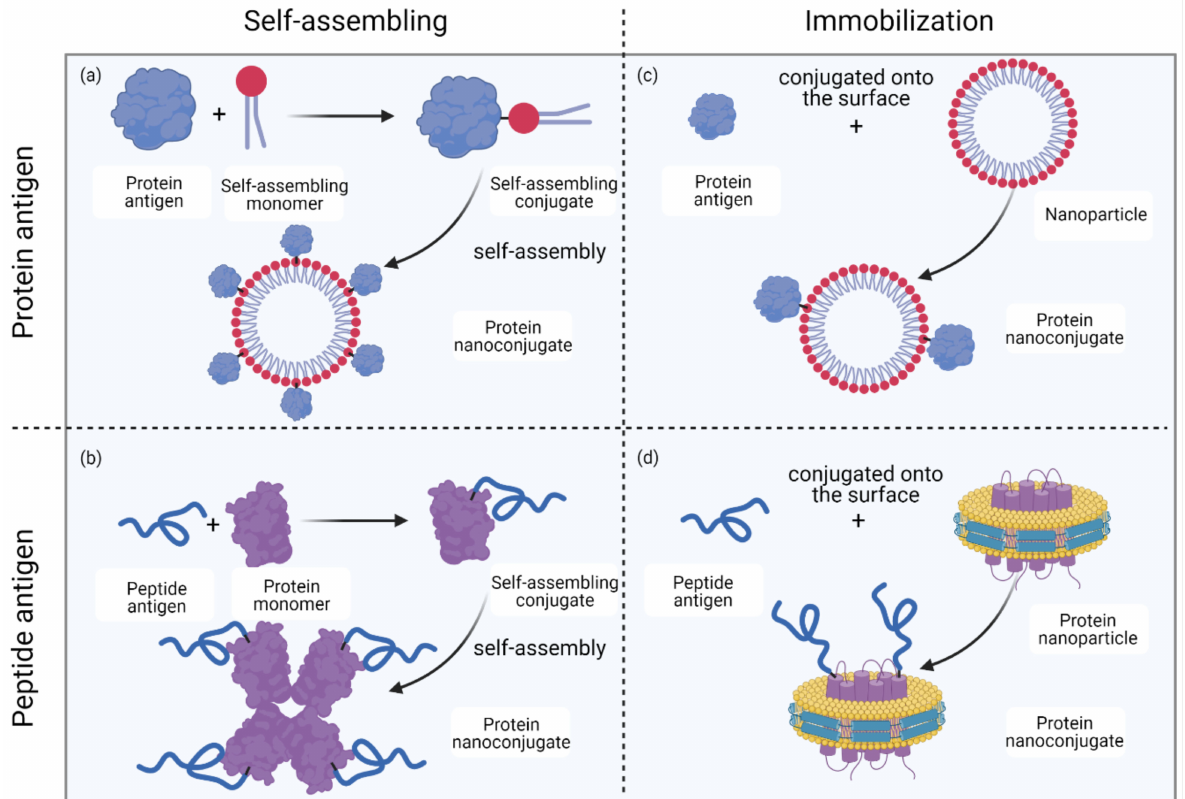
Figure 12. Methods for protein nanoconjugate formation. ( a ) Protein antigens are conjugated to self-assembling monomers; the conjugates then self-assemble into protein nanoconjugates. ( b ) Peptide antigens are conjugated to protein monomers; the conjugates then self-assemble into protein nanoconjugates. ( c ) Protein antigens are conjugated to the surface of nanoparticles (NPs) to form protein nanoconjugates. ( d ) Peptide antigens are conjugated to the surface of NPs (for example, lipoprotein NPs) to form protein nanoconjugates. Drawing created with Biorender.com (accessed 26 May